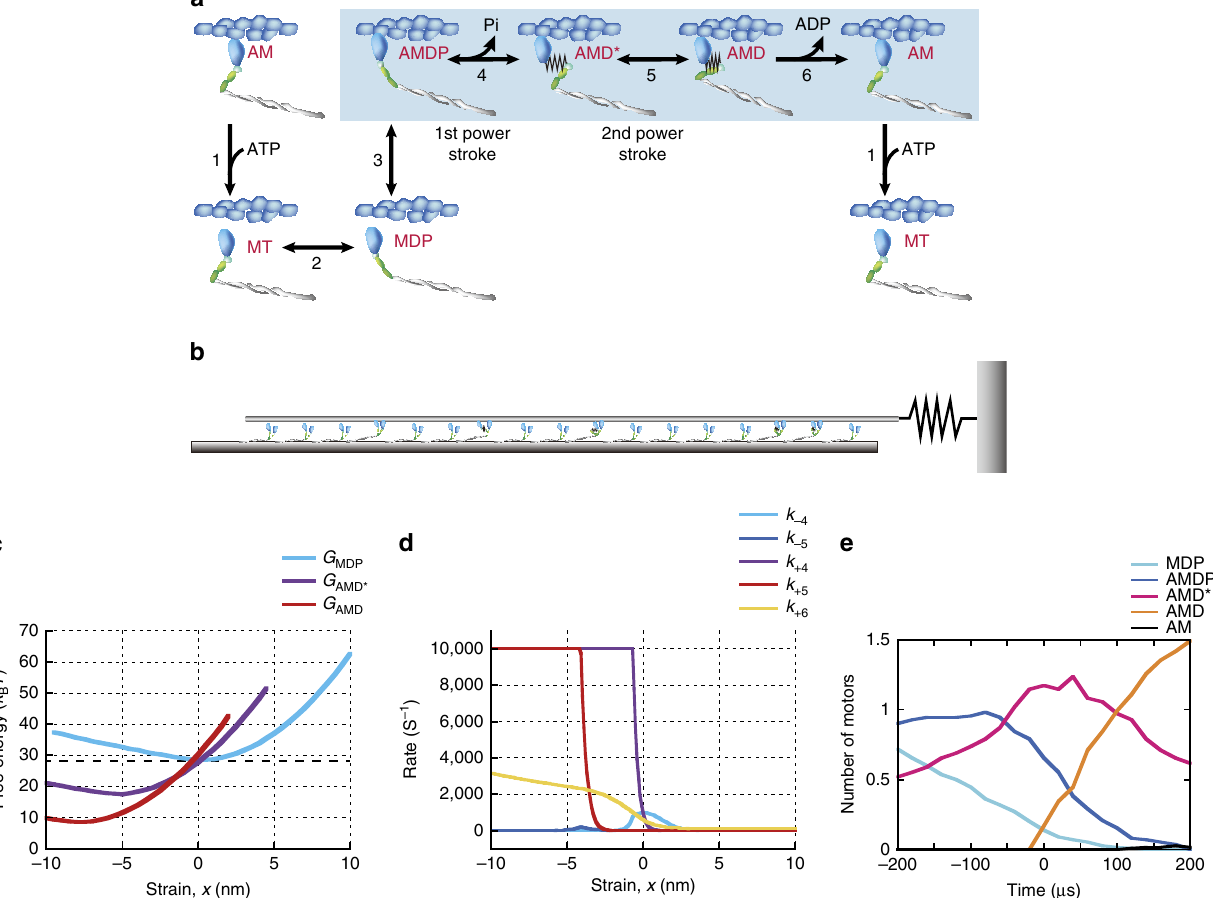
Figure 5 | Simulation model for actin–myosin interaction. ( a ) Kinetic scheme for myosin and actin interaction cycles starting from ATP binding to myosin (AM). A, M, T, D and P are actin, myosin, ATP, ADP and Pi, respectively. Two steps of power stroke execution are accompanied at the transitions towards AMD* and AMD states. See details in the Methods section. ( b ) Schematic of 17 myosin molecules interacting with an actin filament connected to the spring, whose stiffness is equivalent to the trap stiffness of 0.16pNnm (cid:2) 1 used in the experiments. ( c ) Free energy profiles of detached (MDP) and attached states (AMD* and AMD) calculated from the nonlinear elasticity of the myosin head as a function of the strain in the myosin head, x . The black dashed line represents the total free energy of ATP hydrolysis, D E ATP (Methods). The difference in free energy minima between MDP and AMD* or AMD* and AMD are given as D E AMD (cid:3) or D E AMD , respectively (Methods and Table 1). ( d ) Strain-dependent rate constants between four force-generating states ( k 4 , k 5 and k 6 ) given by the Boltzmann factor. Also see details in the Methods section. ( e ) The mean population of each state for power stroke myosin within ± 200 m s of the onset of the step at 1mM ATP. Before the onset of the step ( t o 0), myosins primarily populate either the AMDP or AMD* state and then undergo a transition to the AMD* or AMD state associated with the first or second power stroke during step generation ( t 4